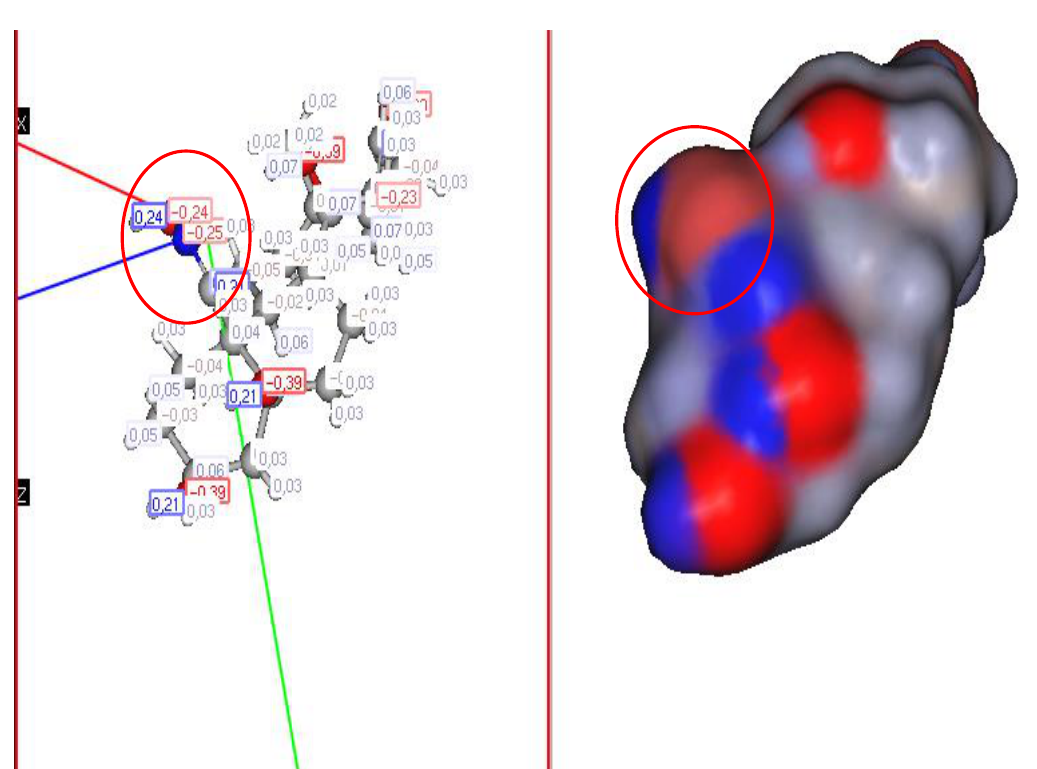
Fig. 7. Distribution of charges in Z-isomer aldoxime